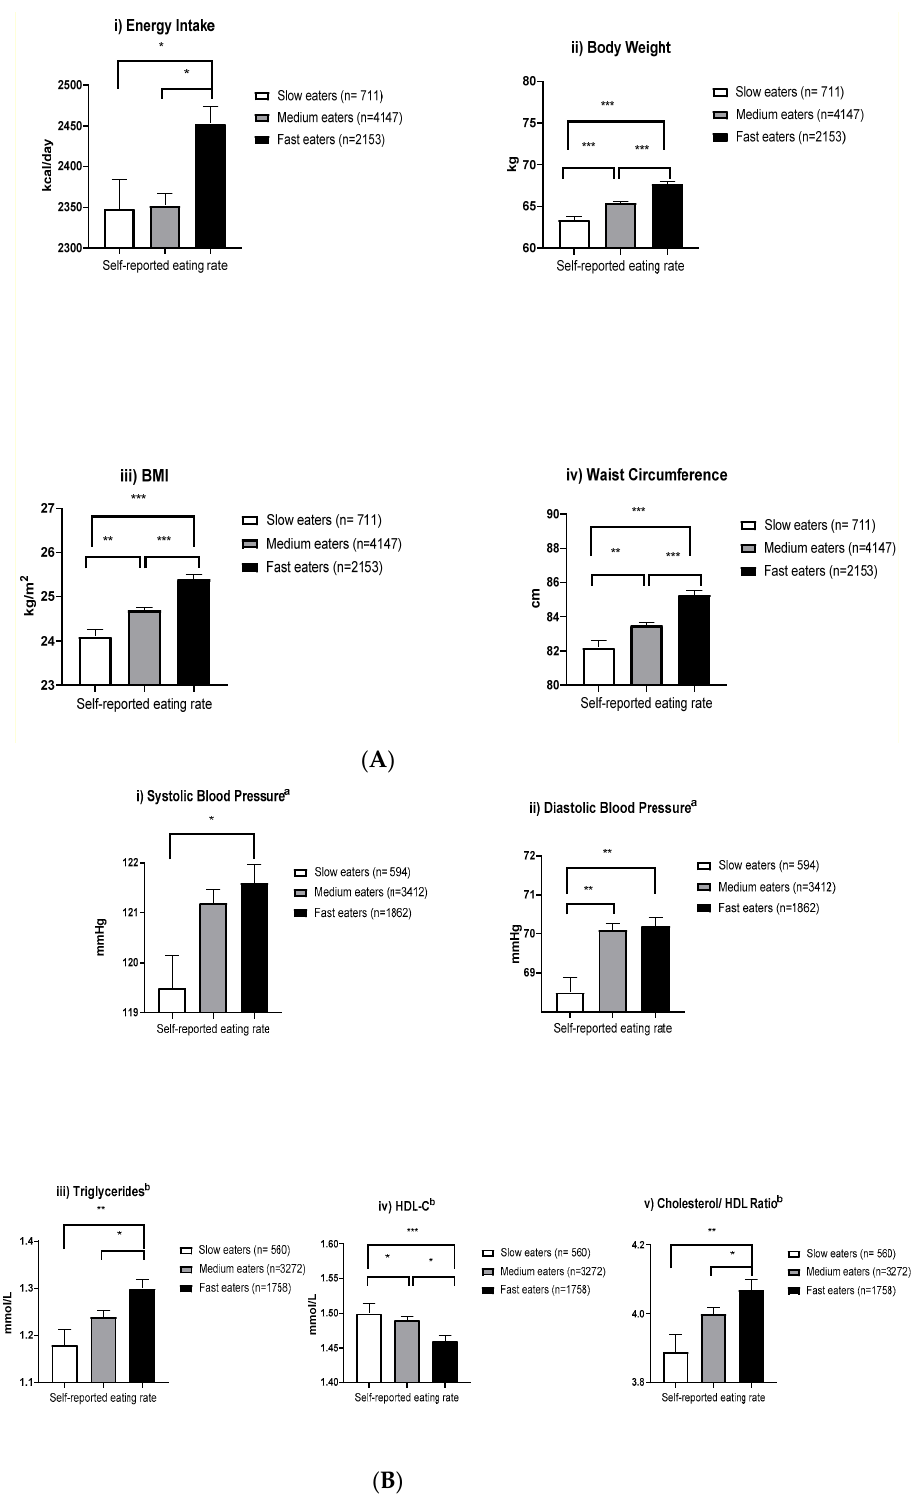
Figure 1. Multivariable ANOVA analyses of the association between self-reported eating rates, and ( A ) Energy intake, and body composition profiles, ( B ) Blood pressure a , and blood metabolic b profiles in the Singapore Multi-Ethnic Cohort 2, n = 7011, after adjusting by age (years), sex, ethnicity, education level, total physical activity (MET-min/week), smoking, and alcohol drinking status. Participants with a diagnosed hypertension, n = 1143; b taking statins, n = 1421 were excluded from the analysis models. Significant different at * p < 0.05, ** p < 0.01, *** p < 0.001. Table 3. Multivariable logistics models of odd ratios (ORs) for being overweight, assessed by BMI and waist circumference (WC) according to self-reported eating rate (SRER) in the Singapore Multi- Ethnic Cohort 2, by sex, ethnic, and age groups. Variables